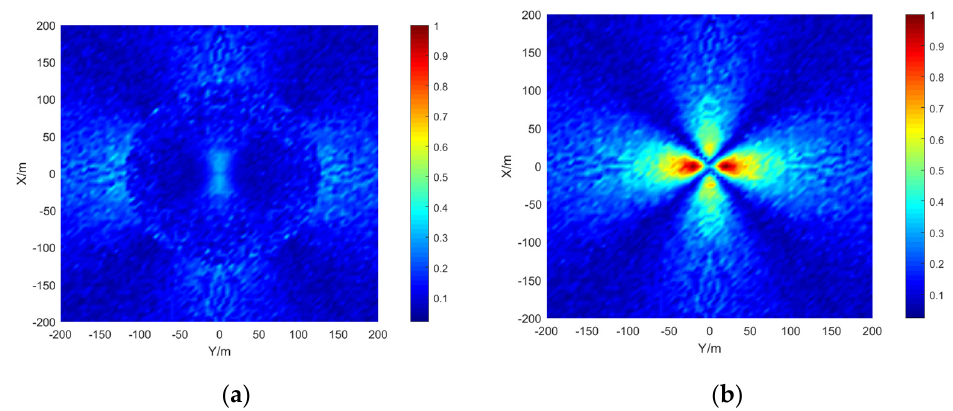
Figure 16. Positioning accuracy of stereo array 2. ( a )combination algorithm ( b )literature 18 algorithm.